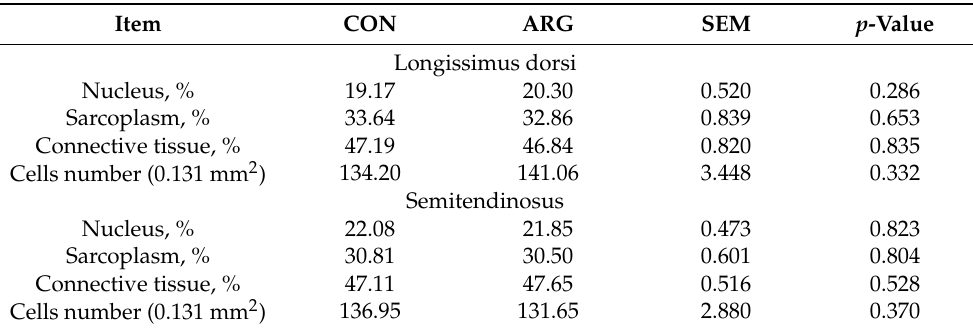
Table 5. Histomorphometric variables of Longissimus dorsi and Semitendinosus of newborn piglets from sows ( n = 23) fed CON or ARG diet.